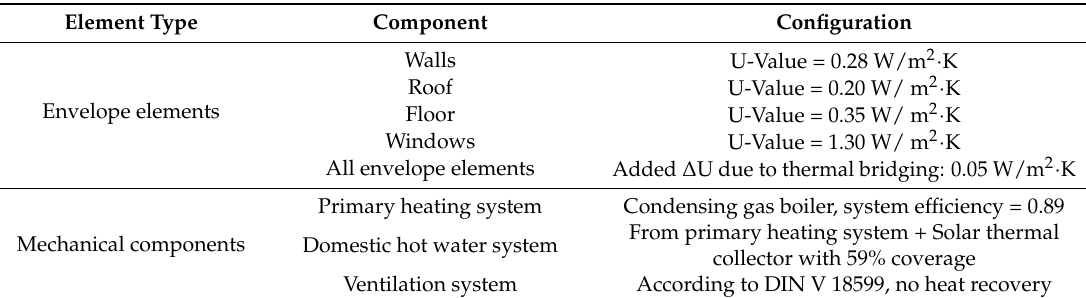
Table 2. Energy performance relevant